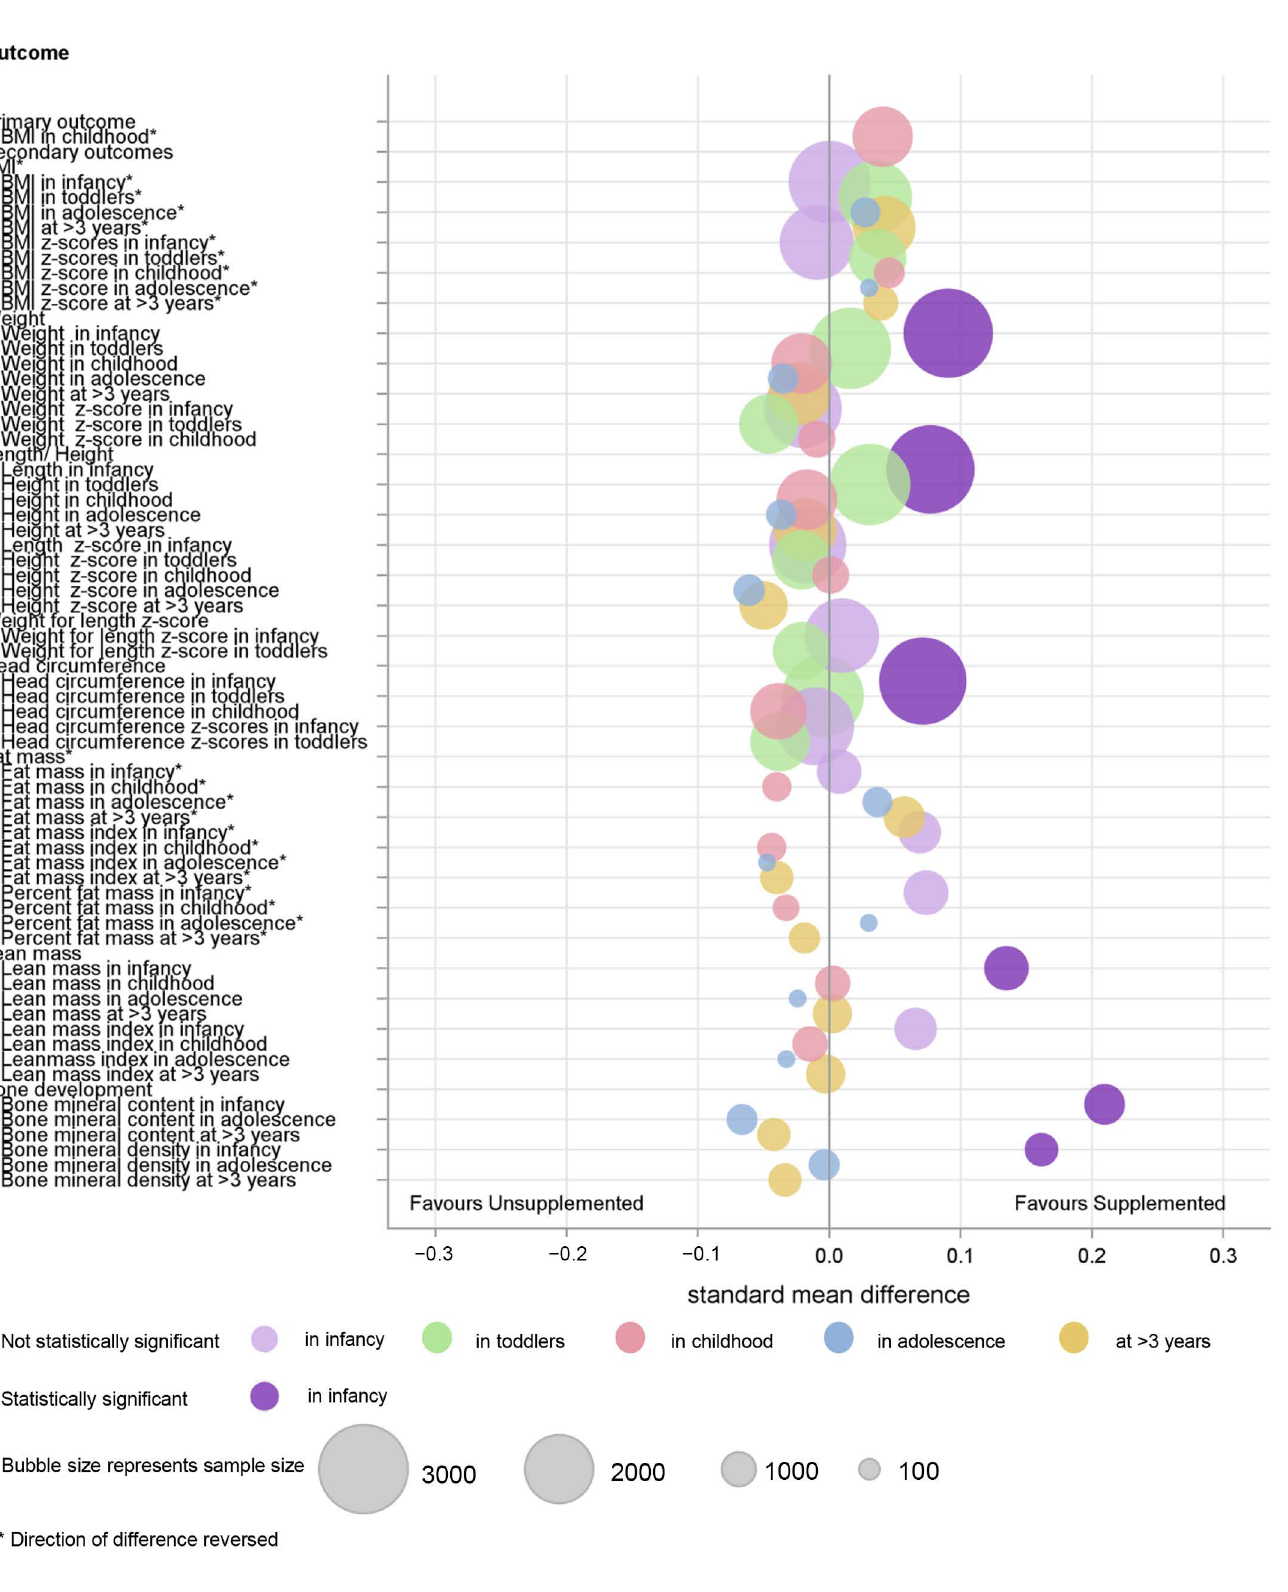
Figure 4. Summary of combined IPD and AD analysis of macronutrient supplements on growth